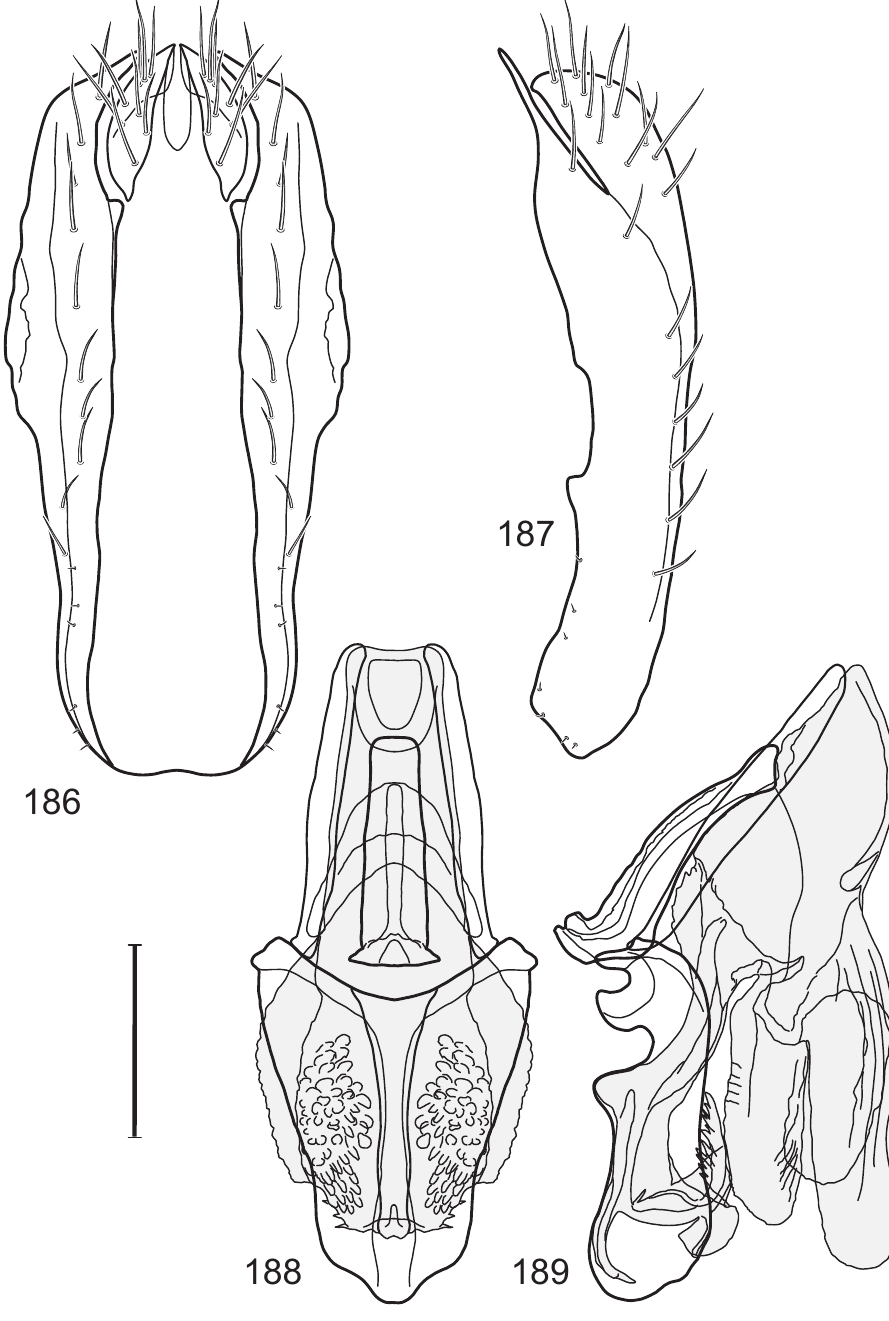
Figures 186–189. Hydrochasma robustum sp. n. (Brazil. Sao Paulo: Praia Puruba) 186 epandrium and cerci, posterior view 187 same, lateral view 188 internal structures of male terminalia (aedeagus [shaded], phallapodeme, gonite, hypandrium), ventral view 189 same, lateral view. Scale bar = 0.1